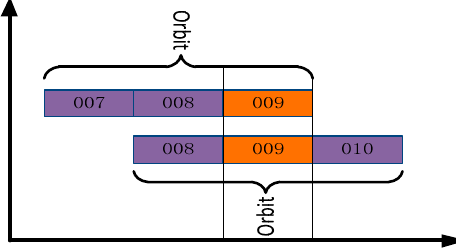
Figure 15. Comparison Strategy of IGSO-03. Table 6. RMS of orbit overlap comparison at 9 January (unit: m).